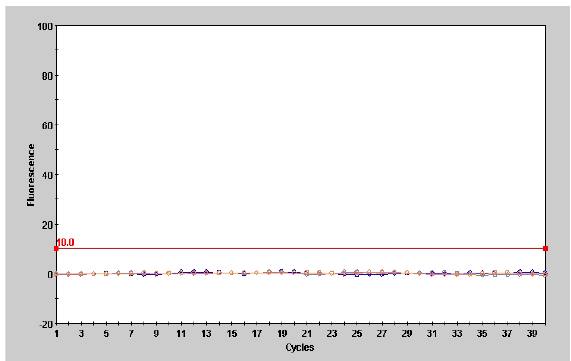
Figure, 4: RT- PCR amplification plot of glycoprotein J for detection of attenuated isolates that lack G gene of ILT virus of three laryngeal and tracheal samples indicate negative result with Quasar labeled probe. Abbas Kareem Co.of broiler breeders 31 weeks, Diala. Al-safaa Co.brown table egg layers 28 weeks, Diwania. Wasit Co.broiler breeders 32 weeks at Wasit